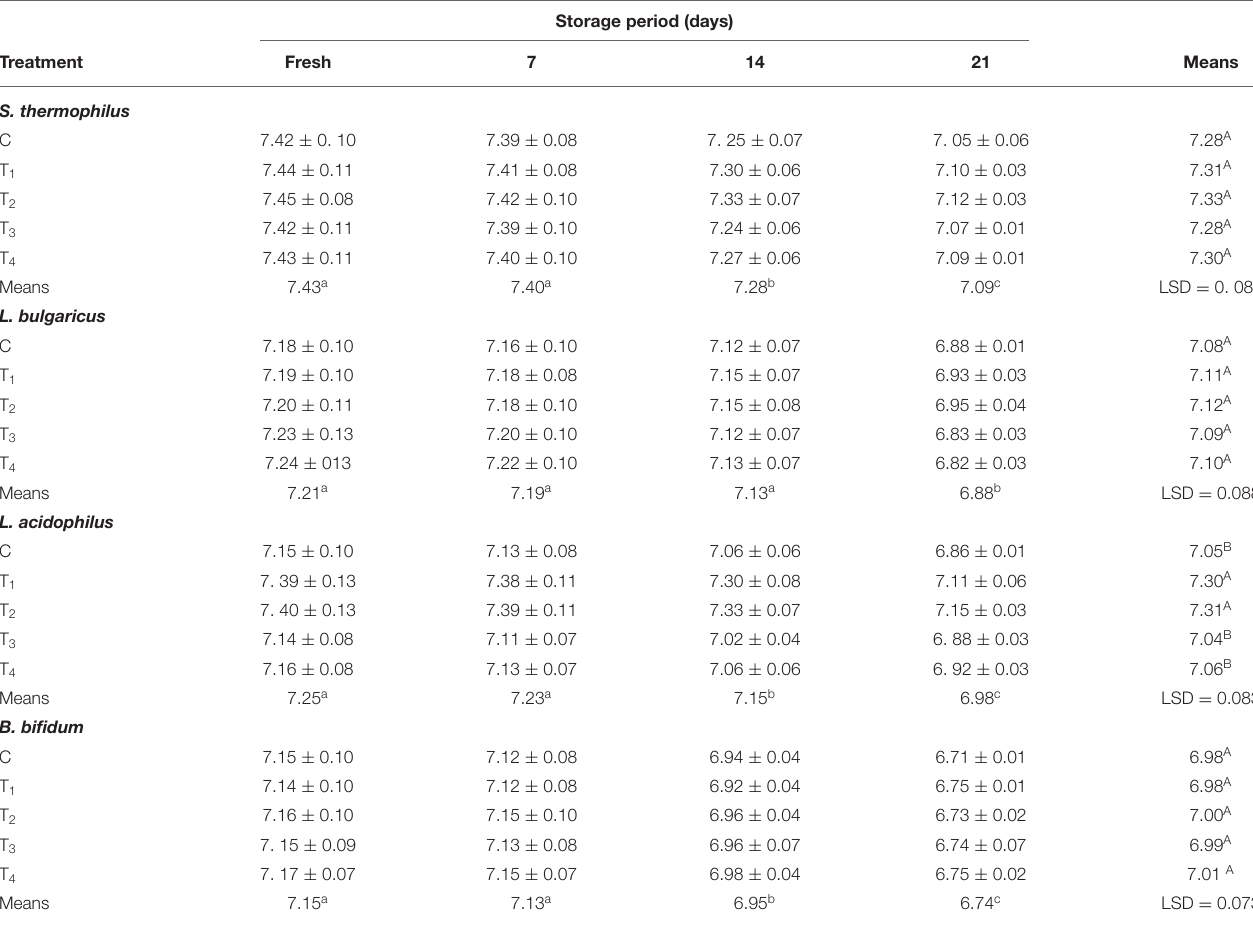
Storage period (days)